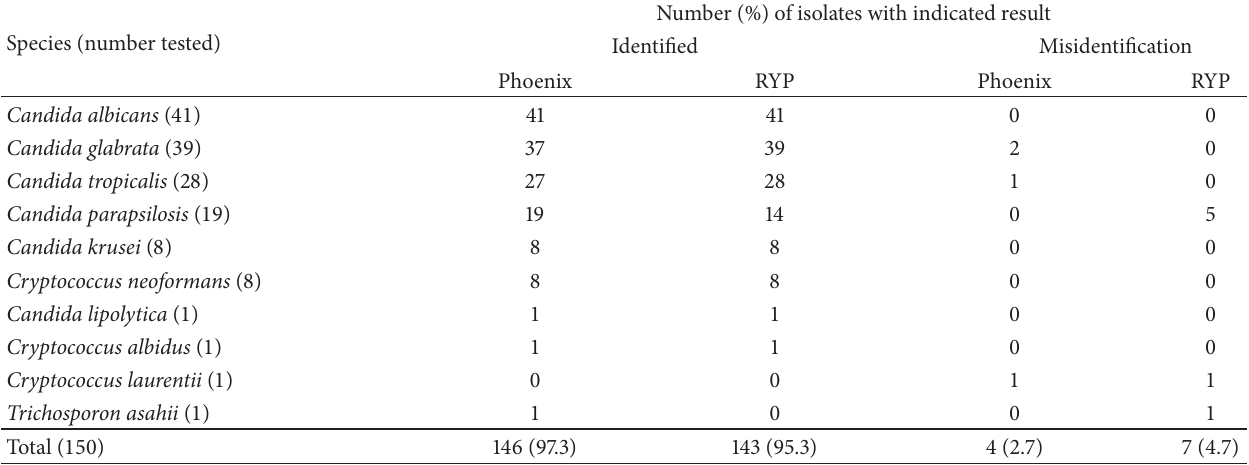
Table 1: Identification results obtained with the Phoenix and RYP systems for 150 clinical yeast isolates a . Number (%) of isolates with indicated result Species (number tested)